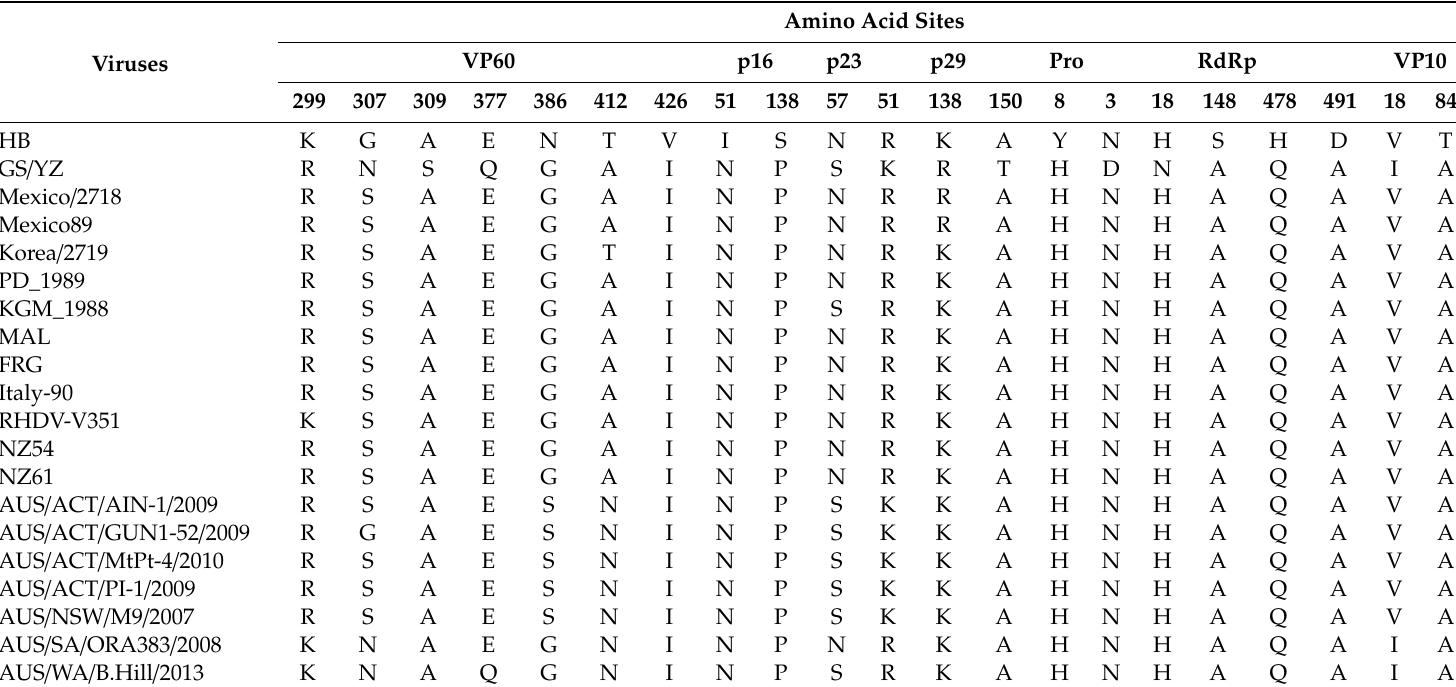
Table 3. The amino acid di ff erences of VP60, nonstructural proteins, and VP10 of the RHDV GS / YZ with the G2 strains.